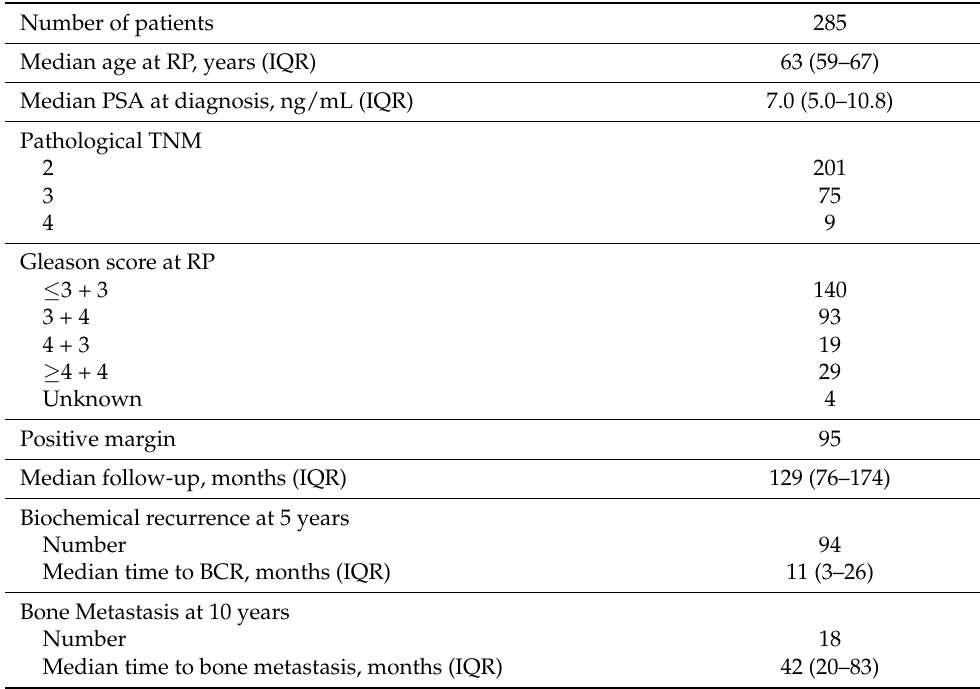
Table 1. Clinical and pathological characteristic of the TF123 tissue microarray (TMA)